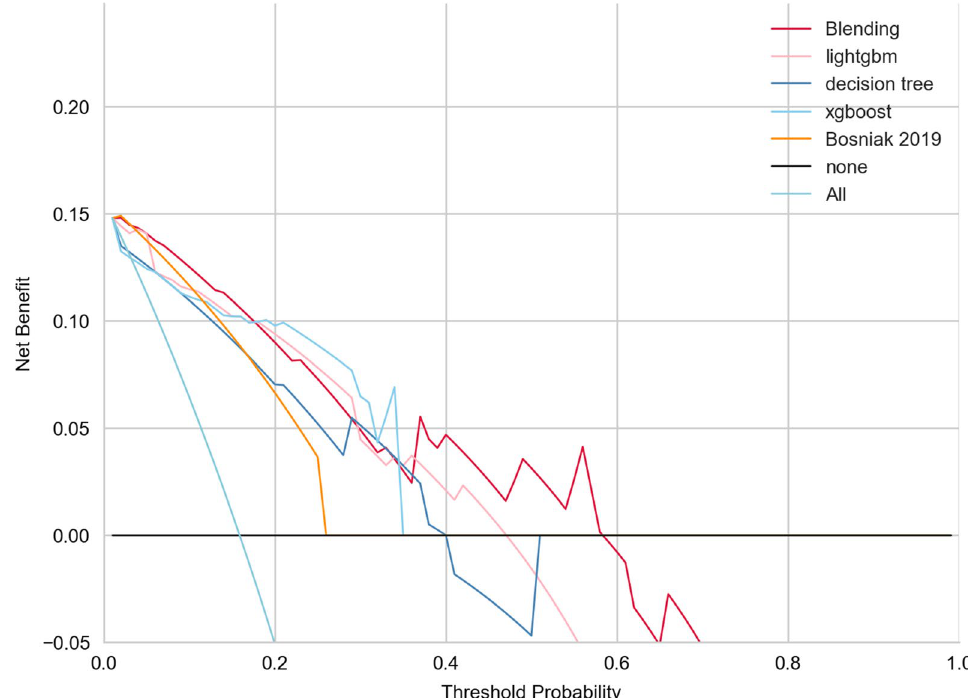
Fig. 6 Decision curve analysis for four machine learning classifiers compared with Bosniak 2019 version in external validation dataset. The net benefit is represented on the y‑axis and corresponding threshold probability is represented on the x‑axis. The blending classifier is represented by the red line. The Bosniak 2019 version is represented by the yellow line. Compared with Bosniak 2019 version, all machine learning model performed better and gave more net